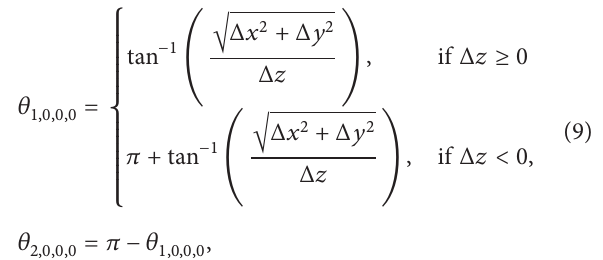
Euler angles (i.e., ( pitch 1 , roll 1 , yaw 1 ) = (0, 0, 0) ) can be given